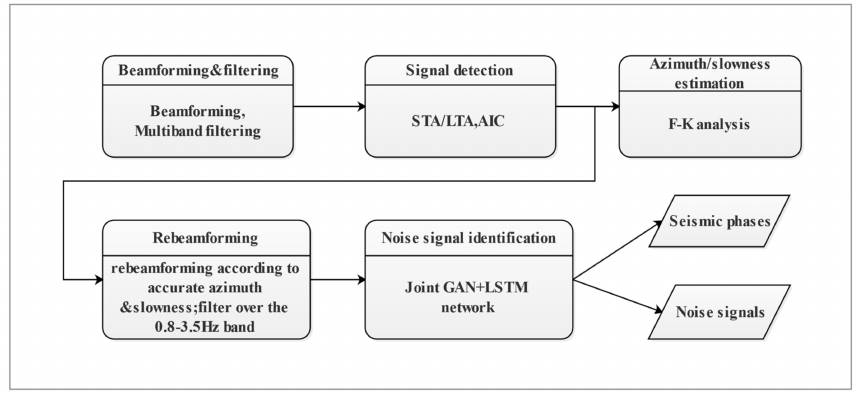
Figure 12. Real-time monitoring array data processing procedure.